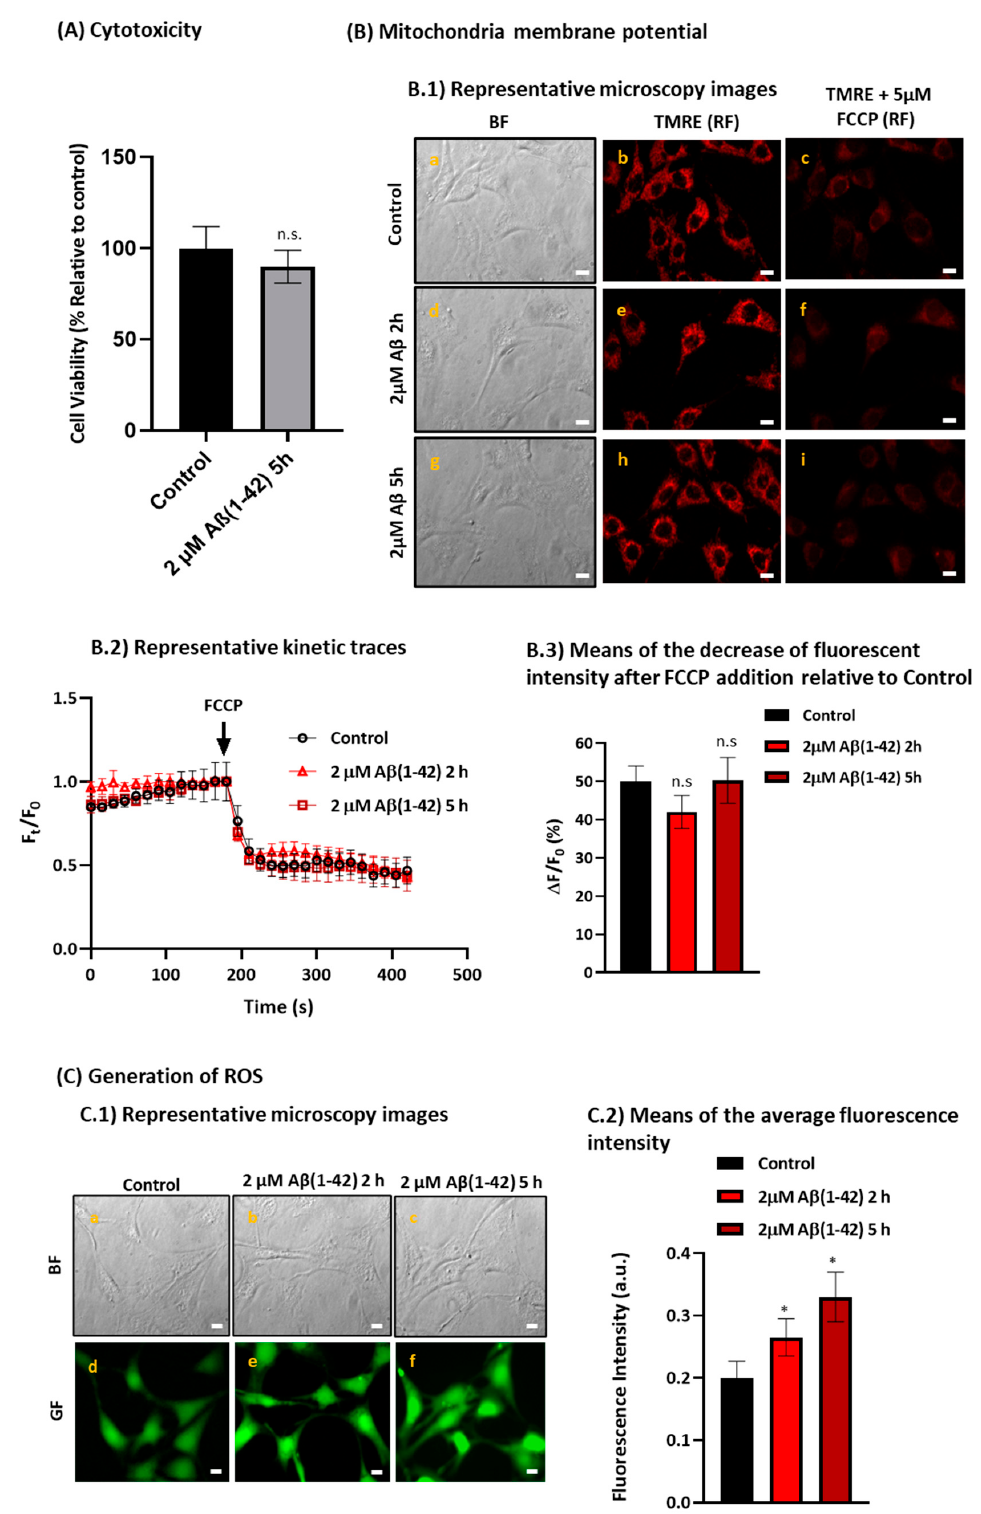
Figure 6. Treatment of HT-22 cells with 2 μ M A β (1-42) up to 5 h incubation does not induce cytotoxicity nor alter the mitochondria membrane potential in the HT-22 cell model but induces a low to moderate increase in ROS production. Untreated cells (control) and HT-22 cells incubated with 2 μ M A β (1-42) for 2 h and/or 5 h at 37 °C and 5% CO 2 were evaluated for (i) cell viability using the MTT assay Panel ( A ); (ii) mitochondria membrane potential using the TMRE assay Panel ( B );